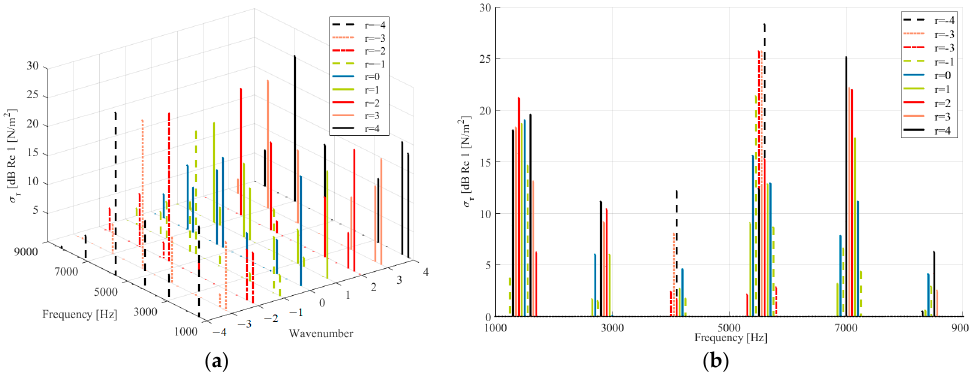
Figure 14. Space-time spectrum of electromagnetic force wave of the motor under 30% dynamic eccentricity conditions: ( a ) space-time spectrum; ( b ) frequency–magnitude correspondence.